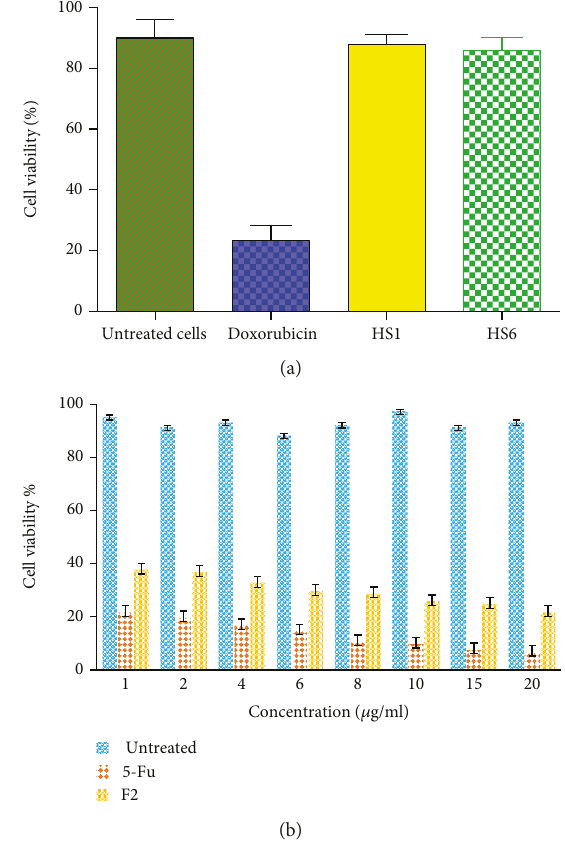
Figure 9: In vitro cytocompatibility sketch of bare Poly (CMCS- g -AA) hydrogels against Vero cell lines (a). In vitro cell cytotoxicity of 5-FU-loaded Poly (CMCS- g -AA) hydrogels against HeLa cell lines (b). Data reported indicates the mean ± SD of ( n = 3 ) independent experiments. The data of control and experimental groups was analyzed statistically with one-way ANOVA. The data was found statistically signi fi cant with ∗∗∗ p value of < 0.001.